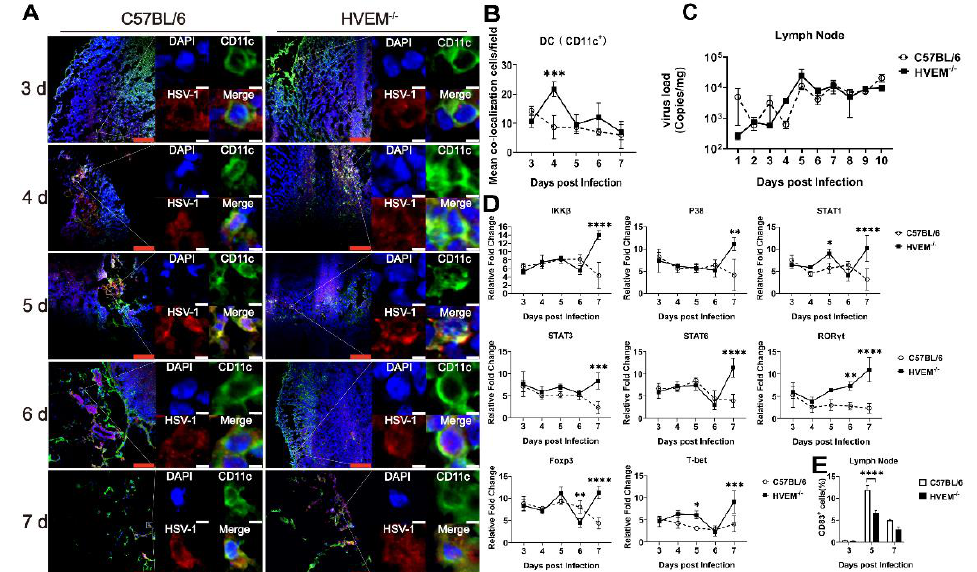
Figure 5. Effect of HSV-1 antigen on the activation of T cells after entering the lymph nodes. ( A ) Representative confocal fluorescence images of HSV-1 expression (red) and CD11c+ (green) in the lymph nodes of C57BL/6 and HVEM −/− mice infected with HSV-1 antigen intracutaneously at 3, 4, 5, 6, and 7 days, taken at 20× magnification under a confocal microscope. The percentage of colocalized cells in the total dendritic cells was based on the observation of 50 fields. The red scale bar is 100 μm, and the white scale bar is 5 μm. ( B ) The colocalization rate of HSV-1 antigen and a dendritic cell marker after infection is shown ( n = 3 per time point in each group). ( C ) Trend of the change in viral load in the lymph nodes within 1 – 10 days after infection ( n = 3 per time point in each group). ( D ) Analysis of the transcription levels of various signaling molecules and transcription factors related to T-cell proliferation in the lymph nodes. The relative expression levels of inflammatory cytokines in mouse tissues were normalized to the level of the blank control group by using the comparative Ct (ΔΔCt) method ( n = 3 per time point in each group). ( E ) Flow cytometry analysis and comparison of CD83 + cells in the lymph nodes within 3, 5, and 7 days after infection ( n = 3 per time point in each group). Statistical significance was assessed by two-way ANOVA with Holm – Sidak adjustment for multiple comparisons (*, p < 0.05; **, p < 0.01; ***, p < 0.001; ****, p < 0.0001).